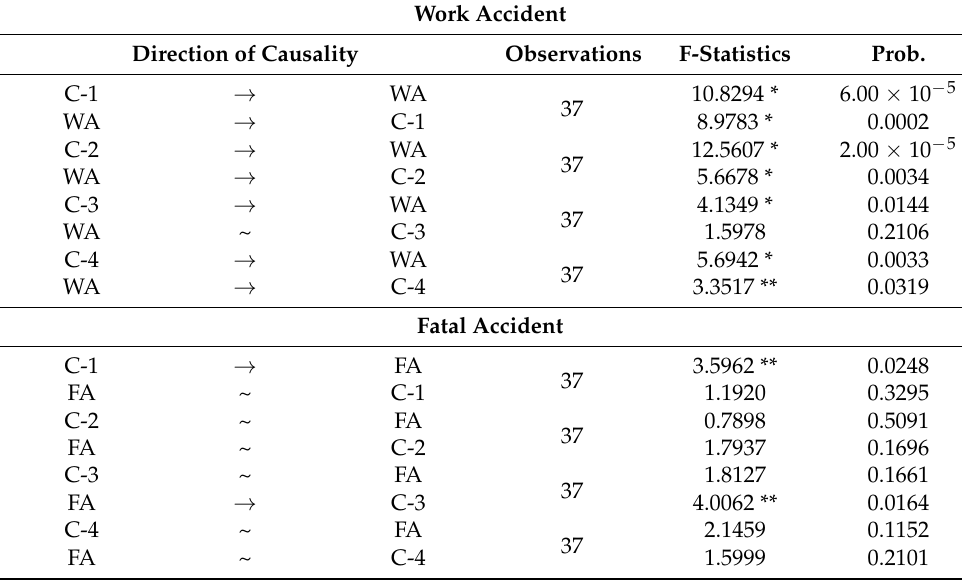
Table 7. Granger causality test between selected